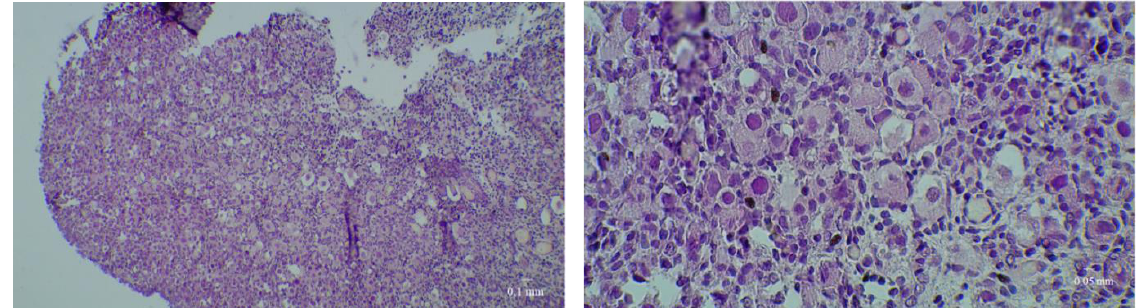
Figure 2. Fresh fetal ovarian tissue before culture. Slices colored before culture with hematoxylin- eosin-safran at low and high magnification.